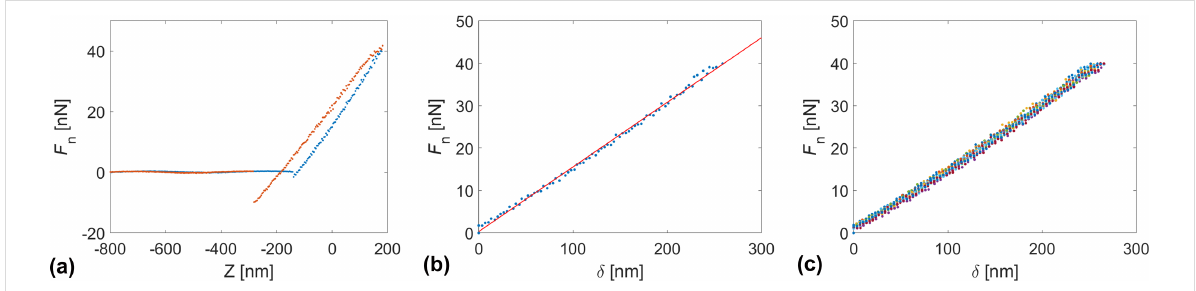
Figure 1: (a) Typical force–distance F n ( Z ) curve recorded with a SiO x tip on the eutectic Ga–In–Sn melt at room temperature; the blue markers indi- cate the approach part, while the orange markers indicate the retraction part. (b) Force–penetration F n ( δ ) curve, calculated from the approach part of the F n ( Z ) curve in (a) and its corresponding fit in red. (c) Superposition of 15 F n ( δ ) curves recorded under the same conditions, that is, temperature and approach velocity.